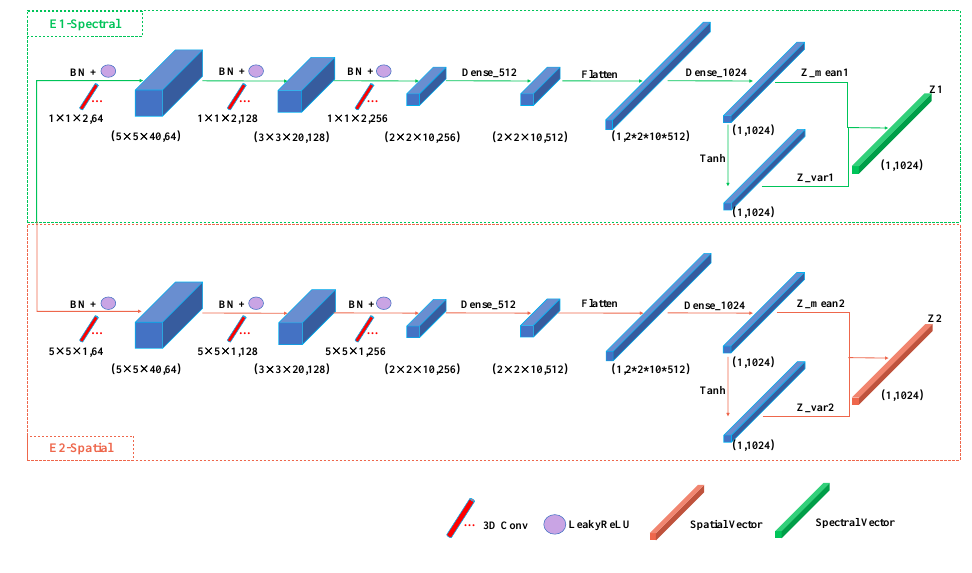
Figure 4. The dual-branch Encoder in CSSVGAN. Table 1. The implementation details of the Spectral feature extraction E 1 .